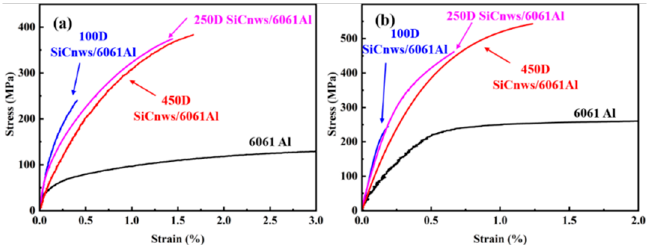
Figure 10. The tensile curves of the representative 6061Al, 20 vol.% 100D, 250D and 450D SiCnw/6061Al composites. ( a ) Annealed, ( b ) Peak-aged.